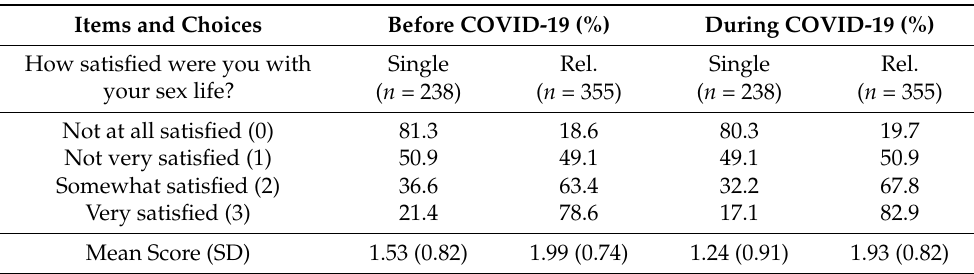
Table 4. Sexual satisfaction before and during COVID-19 social distancing measures, by participant relationship status.